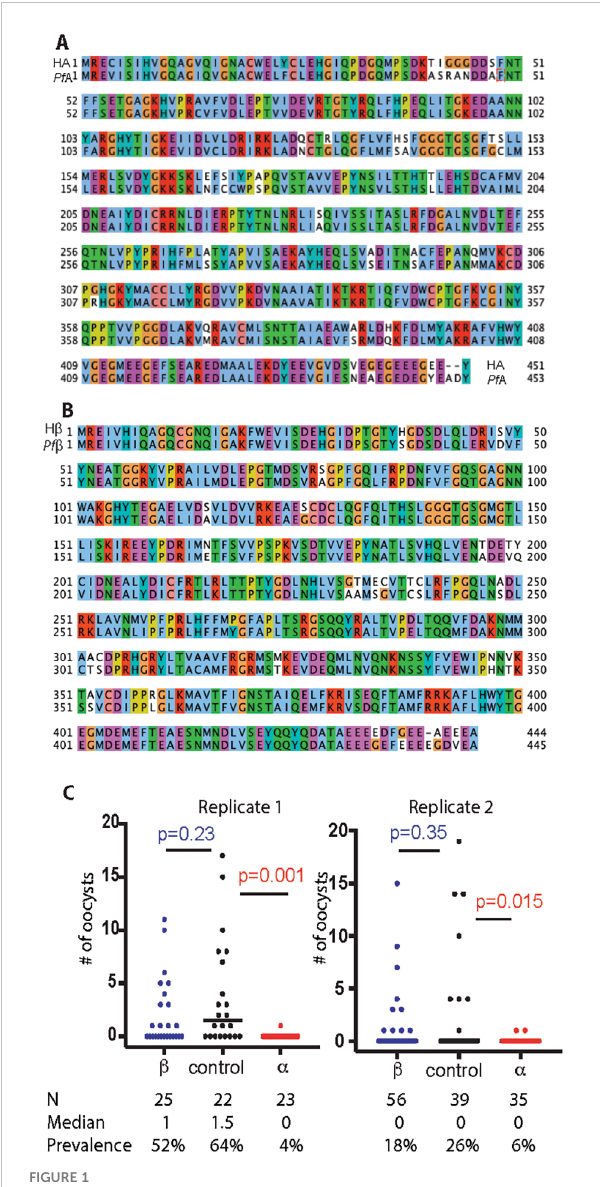
FIGURE 1 Tubulin proteins are highly conserved between human and Plasmodium and the effects of polyclonal anti-tubulin antibodies on oocyst development. (A) Sequence alignment of human a -tubulin (HA) and P. falciparum a -tubulin-1 ( Pf A). Clustal X Colour Scheme was used to show amino acids. (B) Sequence alignment of human b -tubulin (H b ) and P. falciparum b -tubulin-1 ( Pf b ). Clustal X Colour Scheme was used to show amino acids. (C) Standard membrane feeding assays were used to measure Intensity and prevalence of oocysts in the presence of puri fi ed rabbit anti-human a -tubulin polyclonal Ab (labeled with a , 0.01 mg/ml ) and puri fi ed polyclonal Ab against human b -tubulin (labeled with b , 0.01 mg/ml). A non- related puri fi ed rabbit polyclonal Ab (anti-V5, labeled with control, 0.01 mg/ml) was used as the negative control. Mann-Whitney test was used to calculate P-value. N, number of